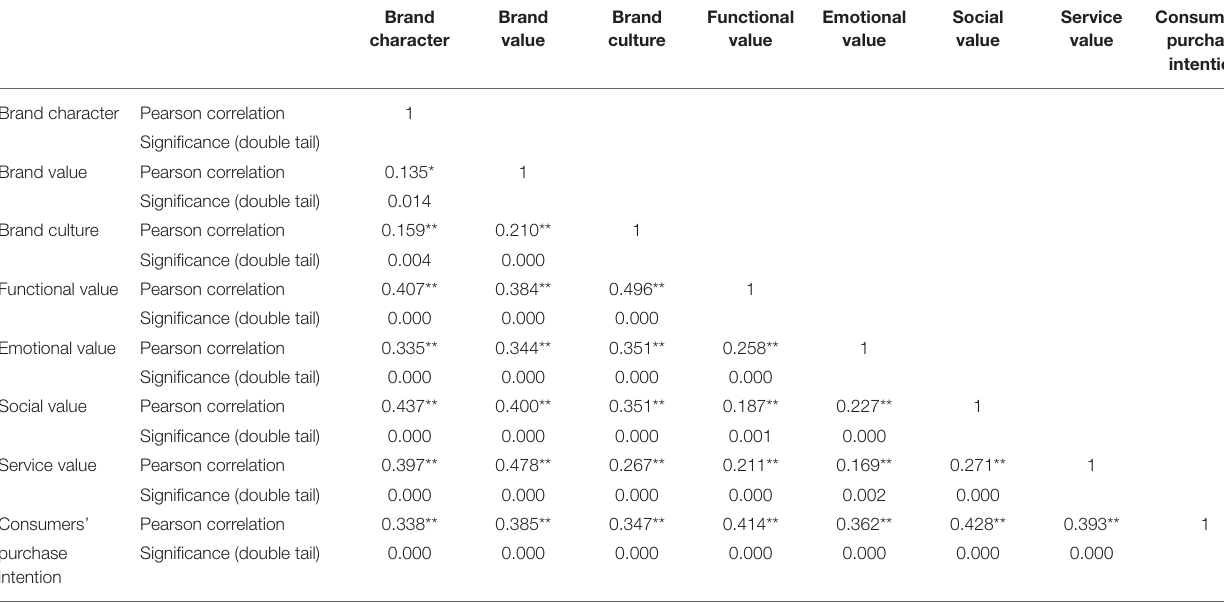
TABLE 1 | Analysis of correlation coefficient.